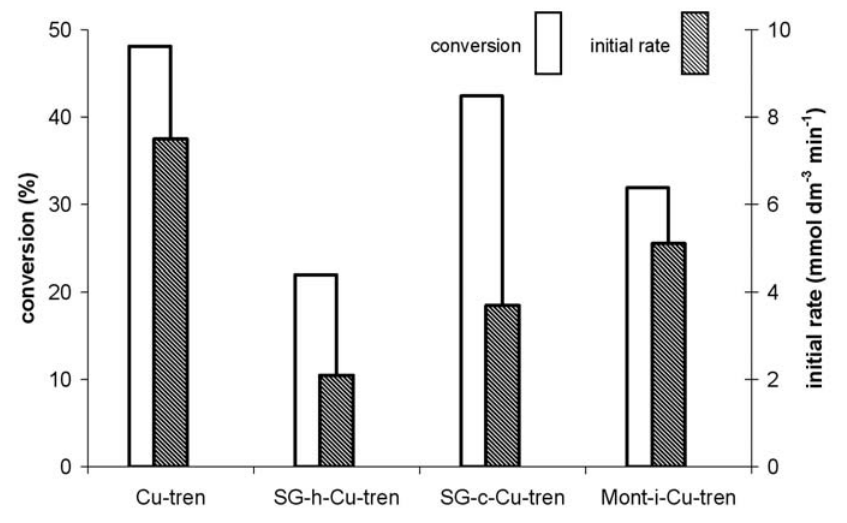
Fig. 9 Catalase activity of the host-free and immobilised Cu-tren complexes described by the conversion (calculated for 120 min reaction time) and initial rate values for dis- proportionation of H 2 O 2